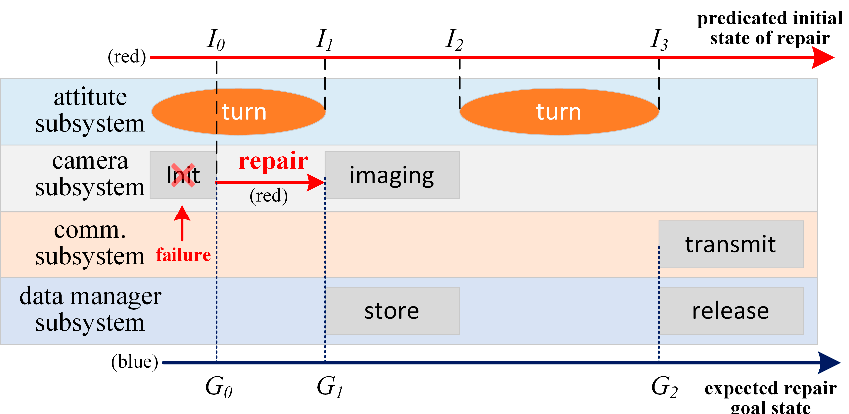
Figure 2. Sketch of difficulties in the repairing of defective actions while performing other actions in a simple imaging task example (the red cross indicates a plan failure. Orange oval actions are executable, and gray rectangle actions are defective. At the same time, the top red line represents the predicted execution state evolution of the spacecraft. The middle red line shows the process of the plan repair within a time limit. The bottom blue line indicates the expected state, which provides a goal reference for the plan repair. When a plan failure happens, it is difficult to decide which initial state would be more appropriate for plan repair and what would be the optimal goal of the repair).